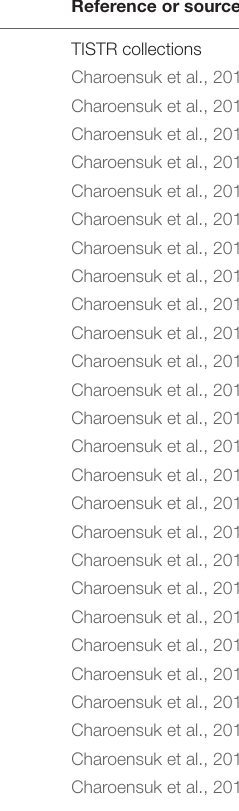
TABLE 1 | List of Zymomonas mobilis strains used in this study.